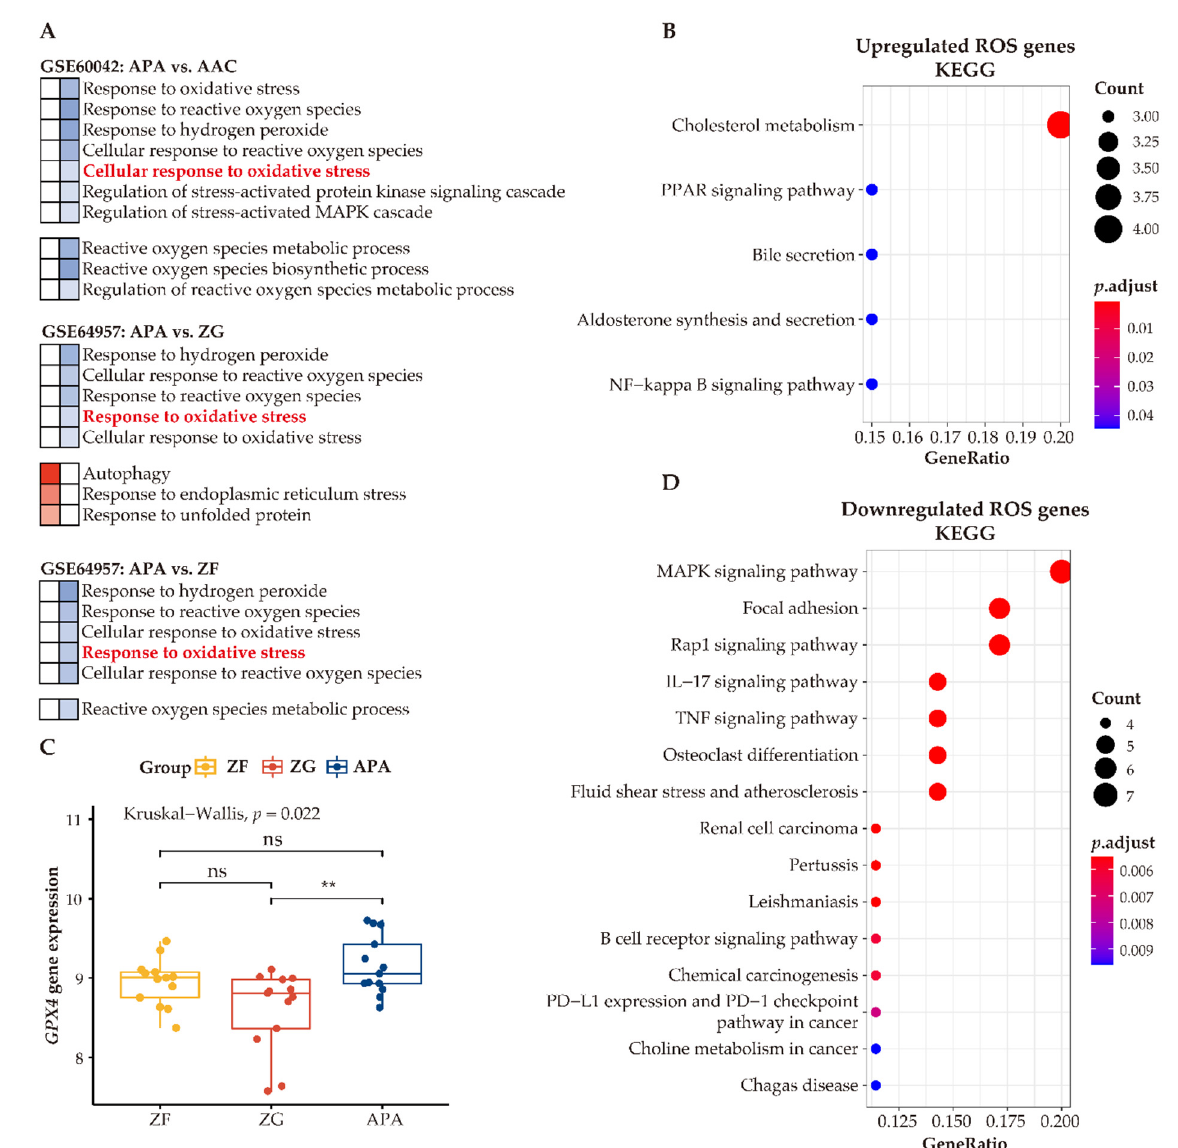
Figure 8. Enhanced antioxidative response pathways in APAs. ( A ) GO analysis of GSEA showing heatmap of ROS-related pathways. Red and blue color indicate upregulated and downregulated pathways ordered by normalized enrichment score in APAs versus AAC, adjacent ZG, and adjacent ZF, respectively. Normalized enrichment score >0 means upregulated pathways (Red), whereas normalized enrichment score <0 means downregulated pathways (Blue). Corresponding pathway enrichments are listed on the side. ( B , D ) indicate KEGG pathways of differentially expressed genes involved in ROS in APA versus adjacent ZG. Overexpressed ROS gene categories associated with metabolism pathways, whereas those downregulated ROS genes are associated with immune-response pathways. ( C ) The GPX4 gene expression between APAs, adjacent ZG, and adjacent ZF. ** p < 0.01 by paired Wilcoxon test. Kruskal–Wallis test was used between groups. APA, aldosterone-producing adenoma; AAC, adjacent adrenal cortex; ZG, zona glomerulosa; ZF, zona fasciculata; ROS, reactive oxygen species.